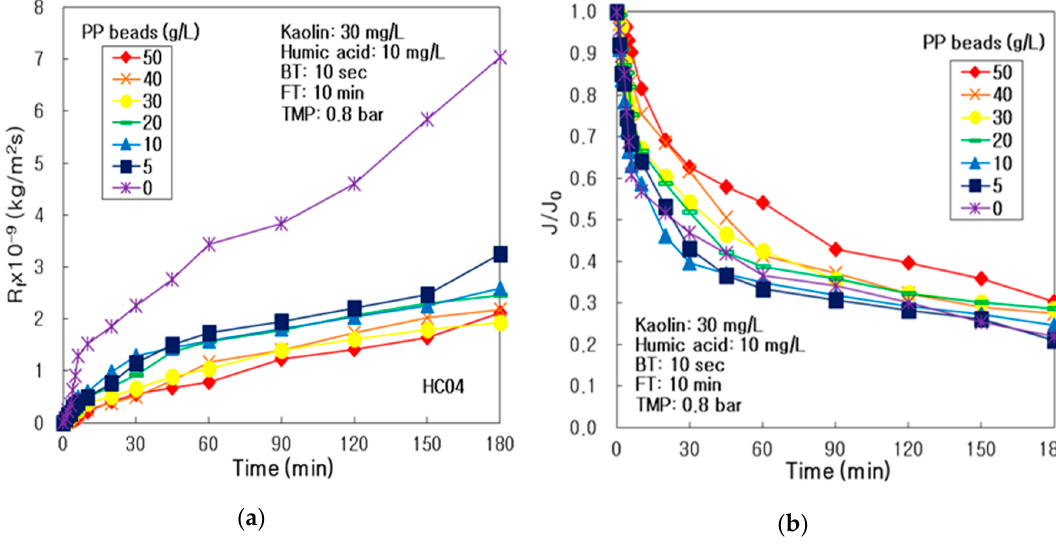
Figure 4. Influence of pure PP particles concentration in the integrated system, of multichannel ceramic MF and PP particles, using UV radiation and periodic air backwashing: ( a ) Membrane fouling resistance and ( b ) dimensionless treated flux.